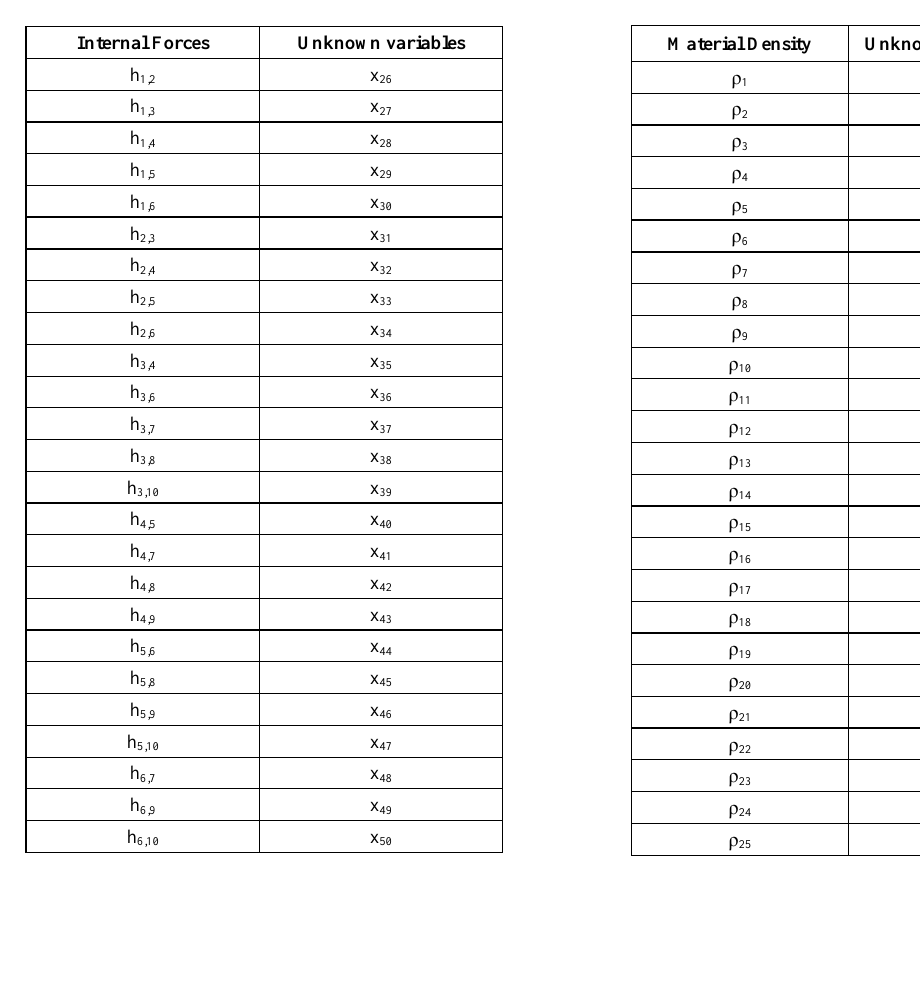
) of the Internal i 25≤i≤50 Forces h i,j